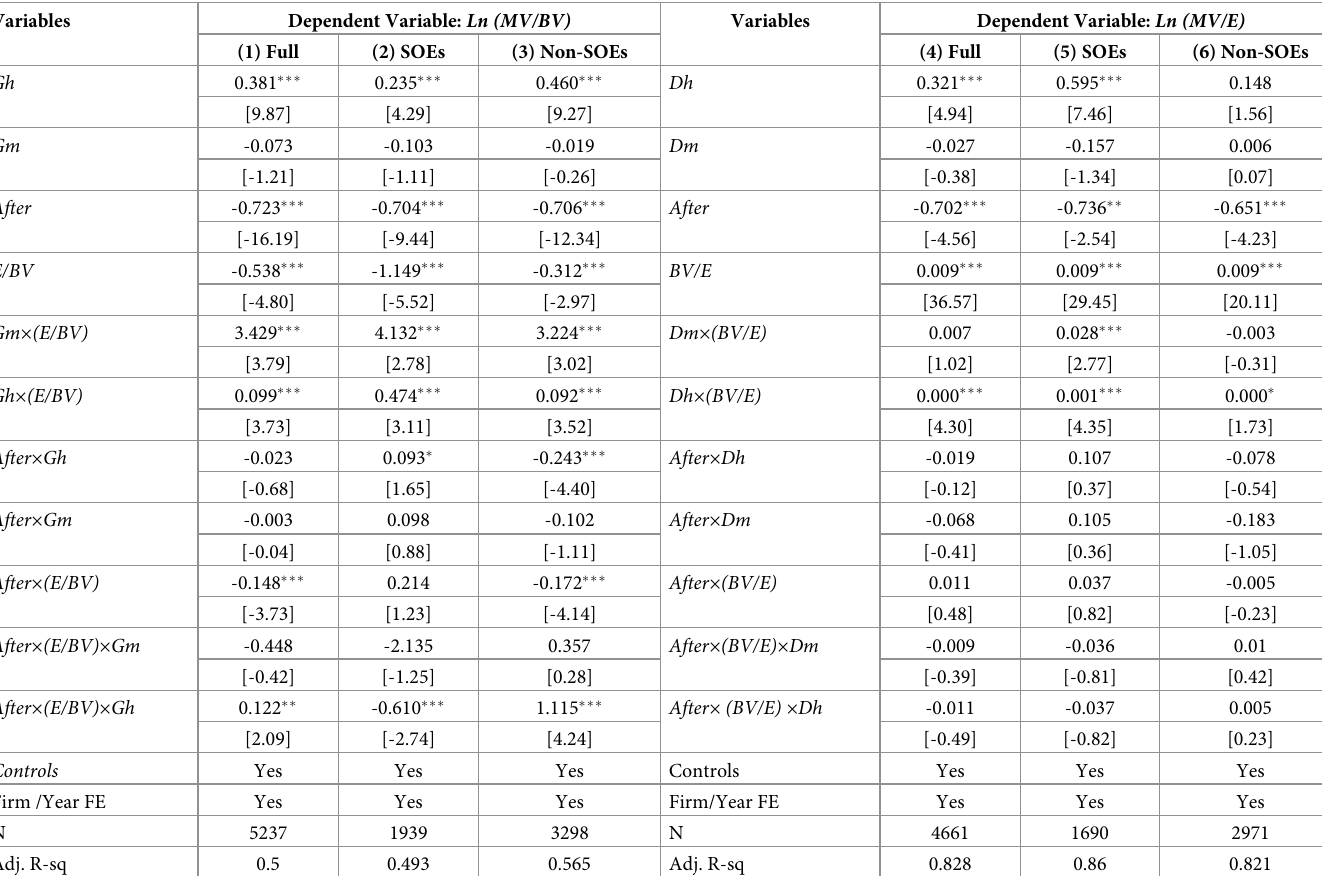
Table 4. Effects of environmental protection tax law on the equity value.